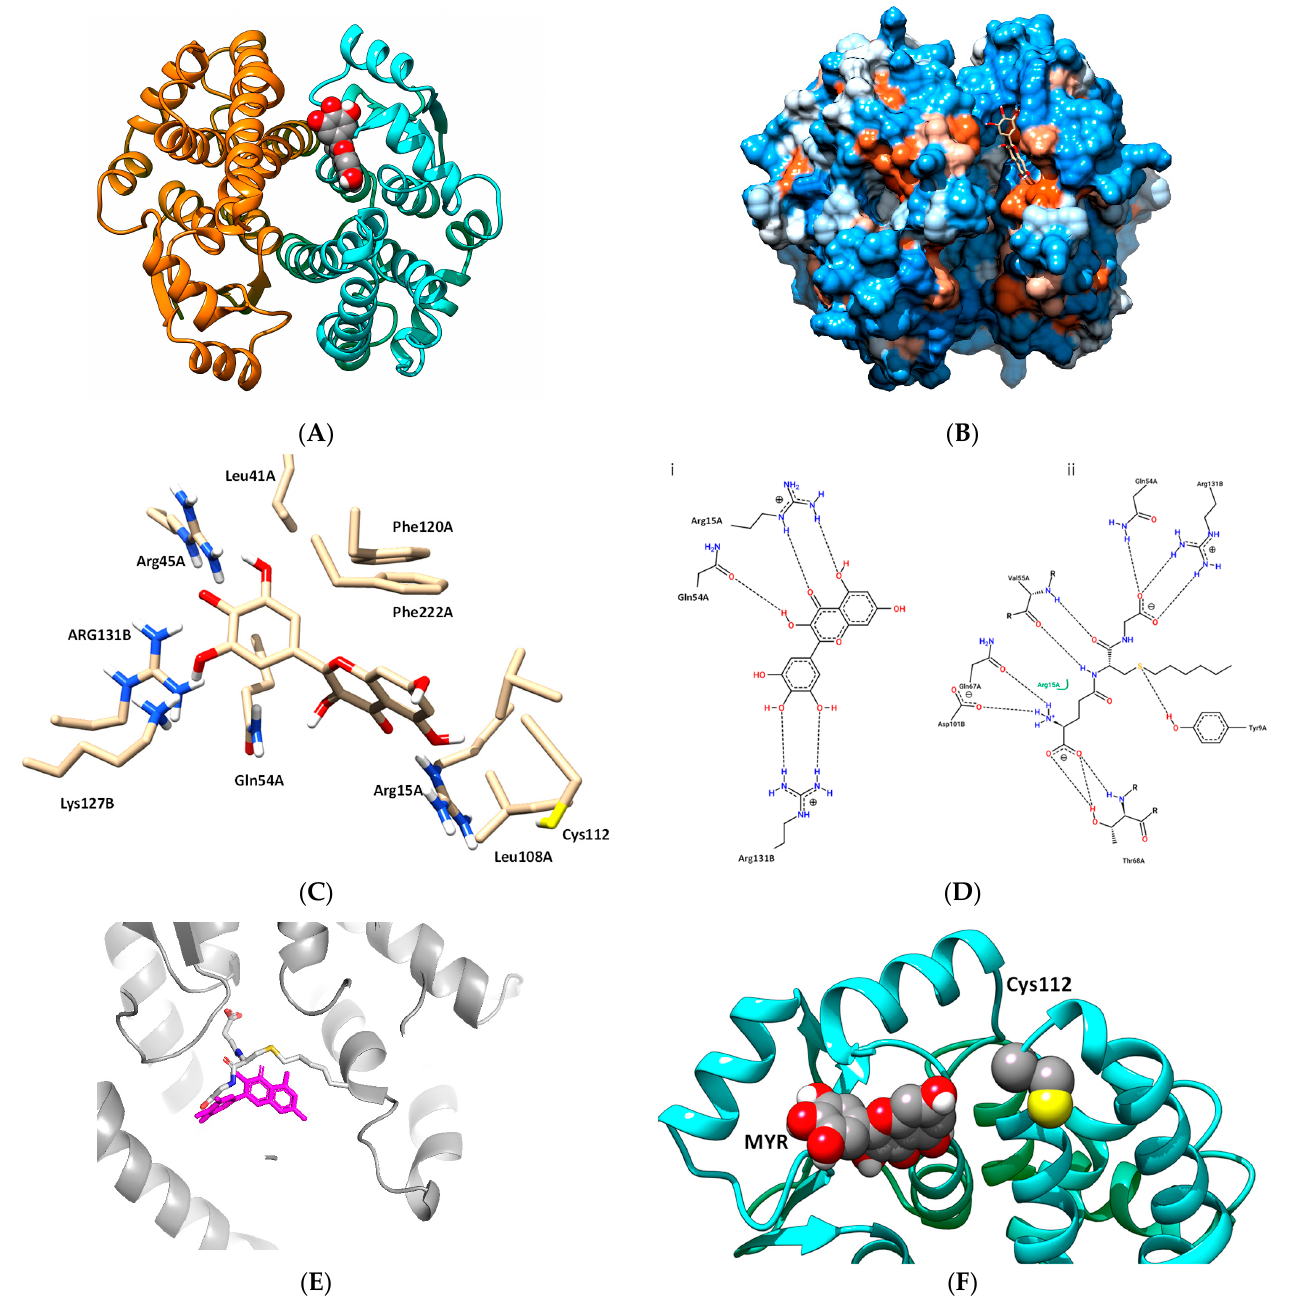
Figure 5. ( A ) The predicted interaction of MYR with hGSTA1–1. MYR bound to the hGSTA1–1 is shown in a ball representation and colored according to the atom type (gray: carbon; blue: nitrogen, red: oxygen). ( B ) The hydrophobicity surface of hGSTA1–1 is depicted and MYR is shown in a stick representation and colored according to the atom type. ( C ) A close-up view of the interactions of MYR with hGSTA1–1. Important side chains that contribute to interaction are shown in a stick representation and labeled. ( D ) Hydrogen bond interaction pattern of MYR (i), and S-hexyl-GSH (ii), upon binding to hGSTA1–1. The figure was created by PoseView [54]. ( E ) Superposition of the MYR and S-hexyl-GSH binding modes. Both ligands are shown in a stick representation. MYR is colored magenta and S-hexyl-GSH is colored according to the atom type. ( F ) The close proximity of MYR, bound to hGSTA1–1, with Cys112.